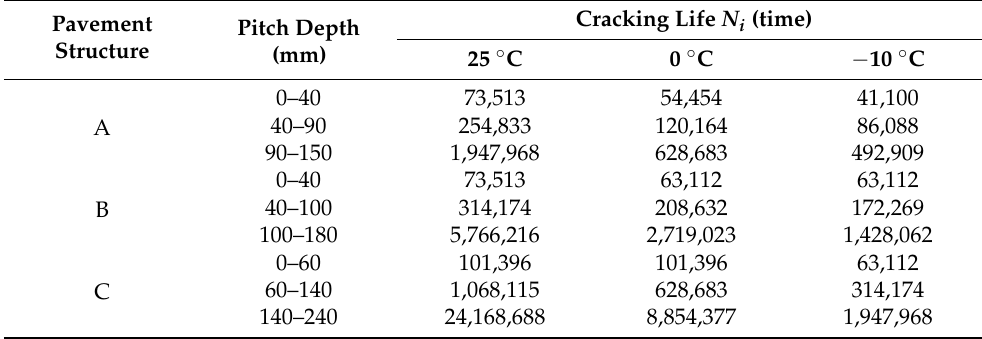
Table 9. Fatigue cracking life of each structural layer of the semirigid base in asphalt pavement. Pavement